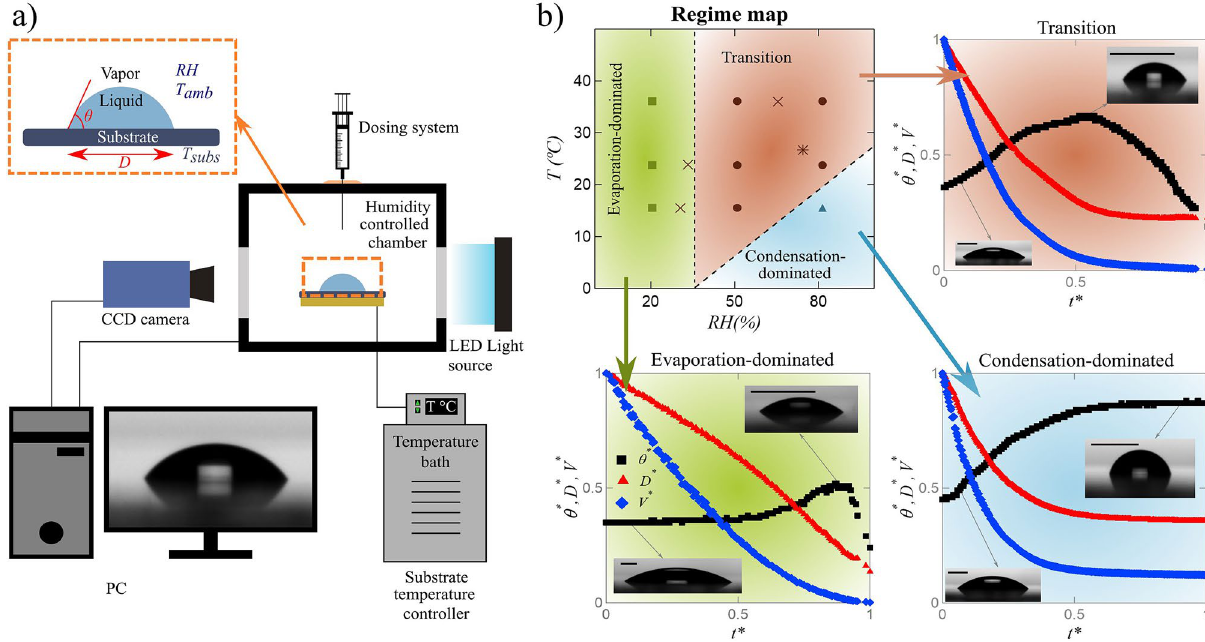
Figure 1. ( a ) Schematic of the experimental setup with macroscopic parameters of droplet shown in the inset; ( b ) regime map of droplet evaporation (top-left) under various relative humidity ( RH ) of surrounding and substrate temperature ( T ), evolutions of nondimensional contact angle, volume, and diameter versus time for evaporation-dominated (bottom-left), transition (top-right), and condensation-dominated (bottom-right) regimes. Each scale bar in droplet images represents a length of 1 mm. The schematic is made using free and open-source software Inkscape (Harrington 63